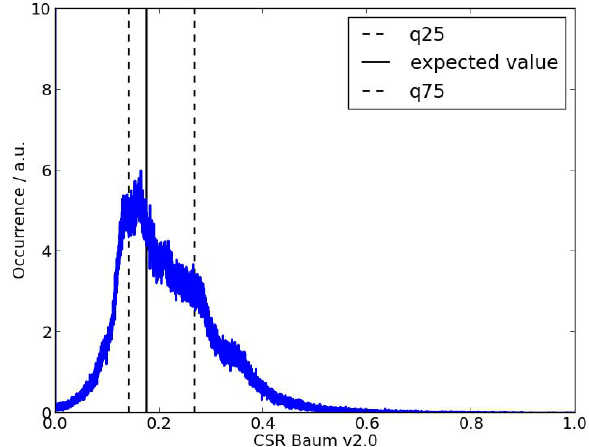
Fig. 7. Normalized distribution of retrieval results using “Baum v2.0” for SEVIRI measurements for which the retrieval with “Baum v3.5” yielded circumsolar ratio (CSR) values between 0.17 an 0.18. Dashed lines mark the 25th and 75th percentiles ( q 25 and q 75 ).